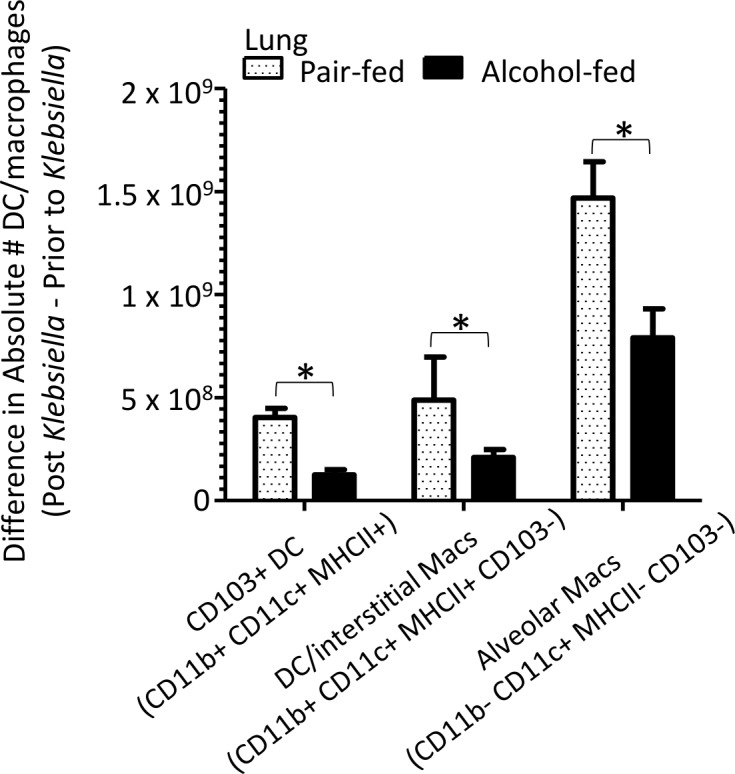
Binge-on-chronic alcohol use alters the levels of pulmonary macrophages and dendritic cells.Difference in absolute number of CD103+ dendritic cells, DC/interstitial macrophages, and aveolar macrophages isolated 48 hrs. post-Klebsiella infection from values obtained pre-infection in alcohol-fed and pair-fed mice. Bars represent the mean of the cell counts post infection minus the cell counts prior to infection ± SEM, * indicates P < 0.05, by ANOVA with Dunn’s correction. N = 10/group.